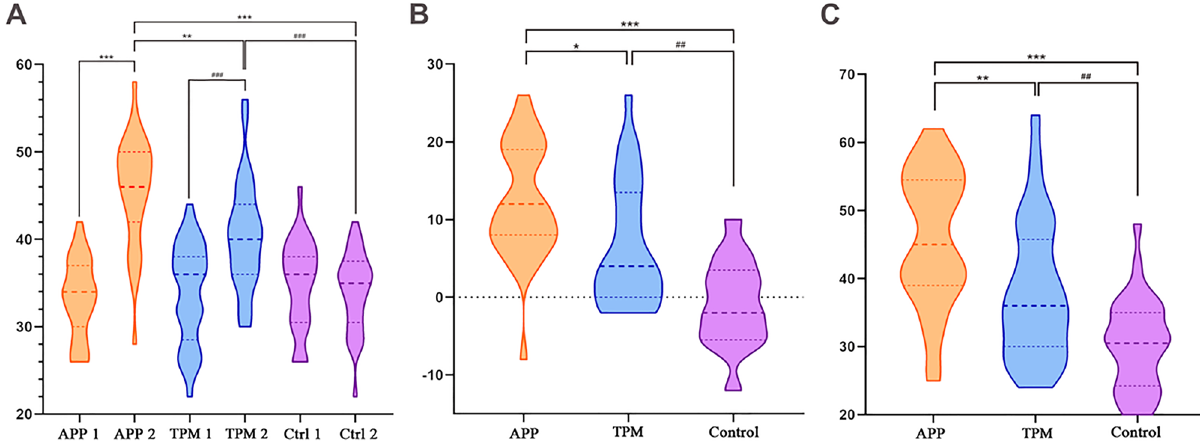
Figure 3. Violin plots. ( A ) The compare of pre- and post-test scores of three groups. ( B ) The progress or retrogress (post-test score – pre-test score) of three groups. ( C ) The compare of scores of simulation test of three groups. (* P < 0.05, ** P < 0.01, *** P < 0.001). TPM: traditional paper media